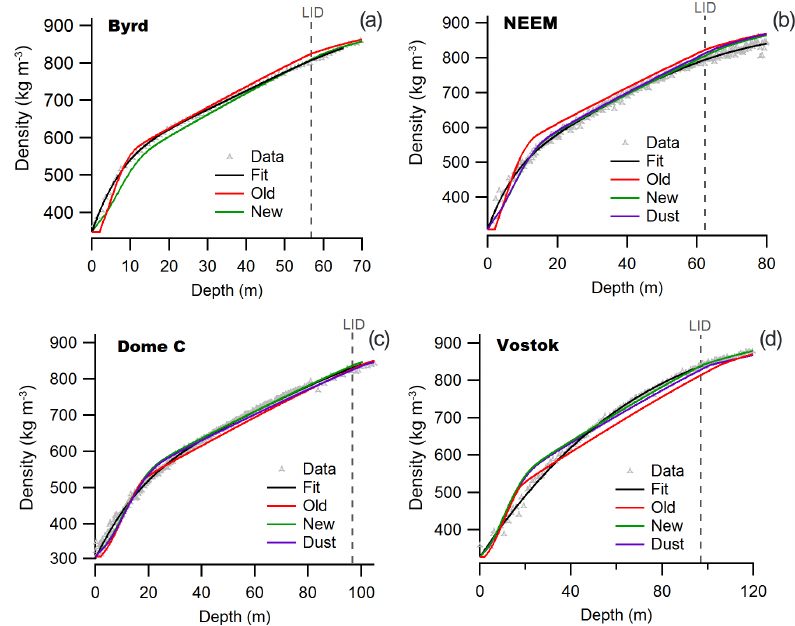
Figure 4. Density profiles of Byrd (a) , NEEM (b) , Dome C (c) , and Vostok (d) . The grey triangles correspond to the data. The black line corresponds to the polynomial fit, the red one to the old simulation, the green one to the new simulation, and the purple one to the new simulation with impurity effect.